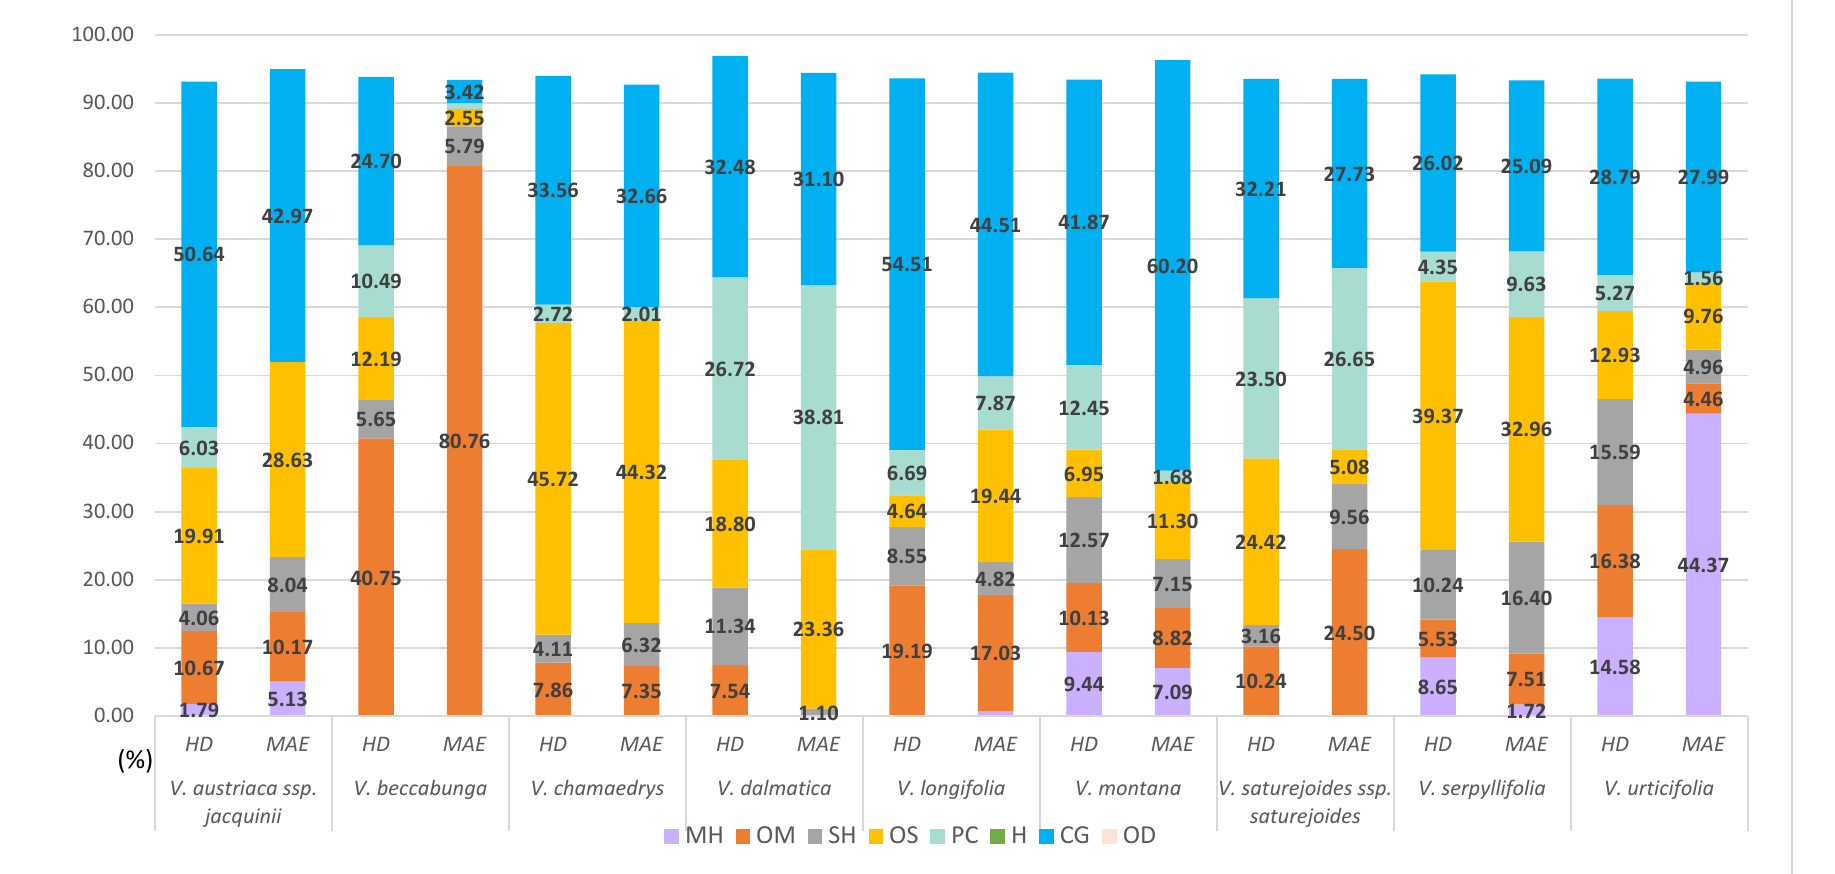
Figure 1. Relative percentage of volatiles in Veronica species from the hydrosols extracted with Clevenger hydrodistillation and microwave-assisted distillation: monoterpene hydrocarbons (MH), oxygenated monoterpenes (OM), sesquiterpene hydrocarbons (SH), oxygenated sesquiterpenes (OS), phenolic compounds (PD), hydrocarbons (H), a common group (CG) of acids, alcohols, and esters and oxygenated diterpene (OD).